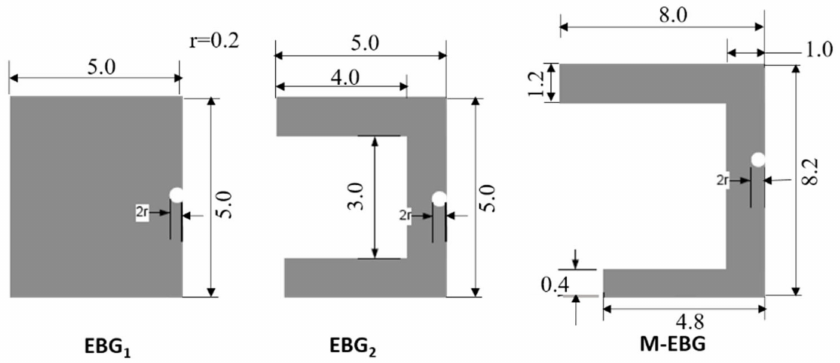
Figure 3. The structures and dimensions (mm) of the